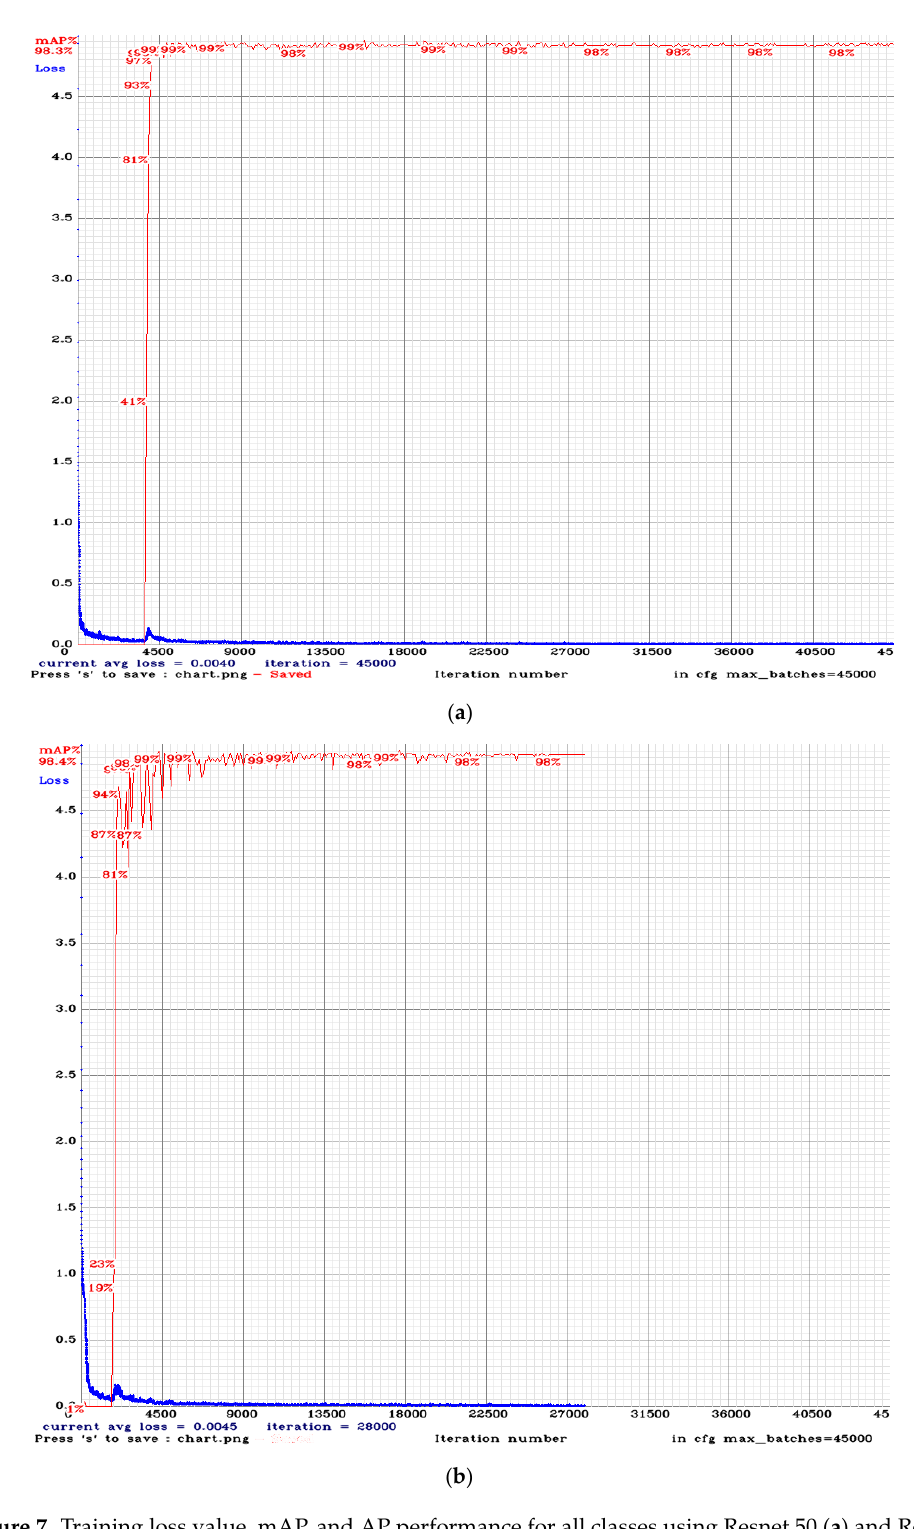
Figure 7. Training loss value, mAP, and AP performance for all classes using Resnet 50 ( a ) and Resnet 50 SPP ( b ).